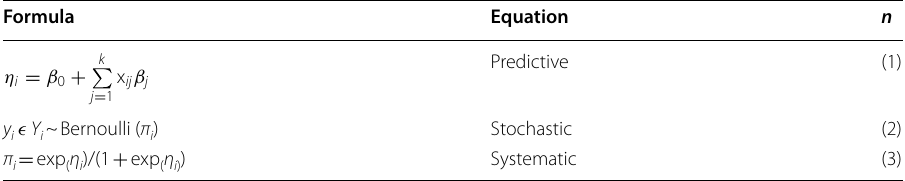
Table 1 Equations for the logit model